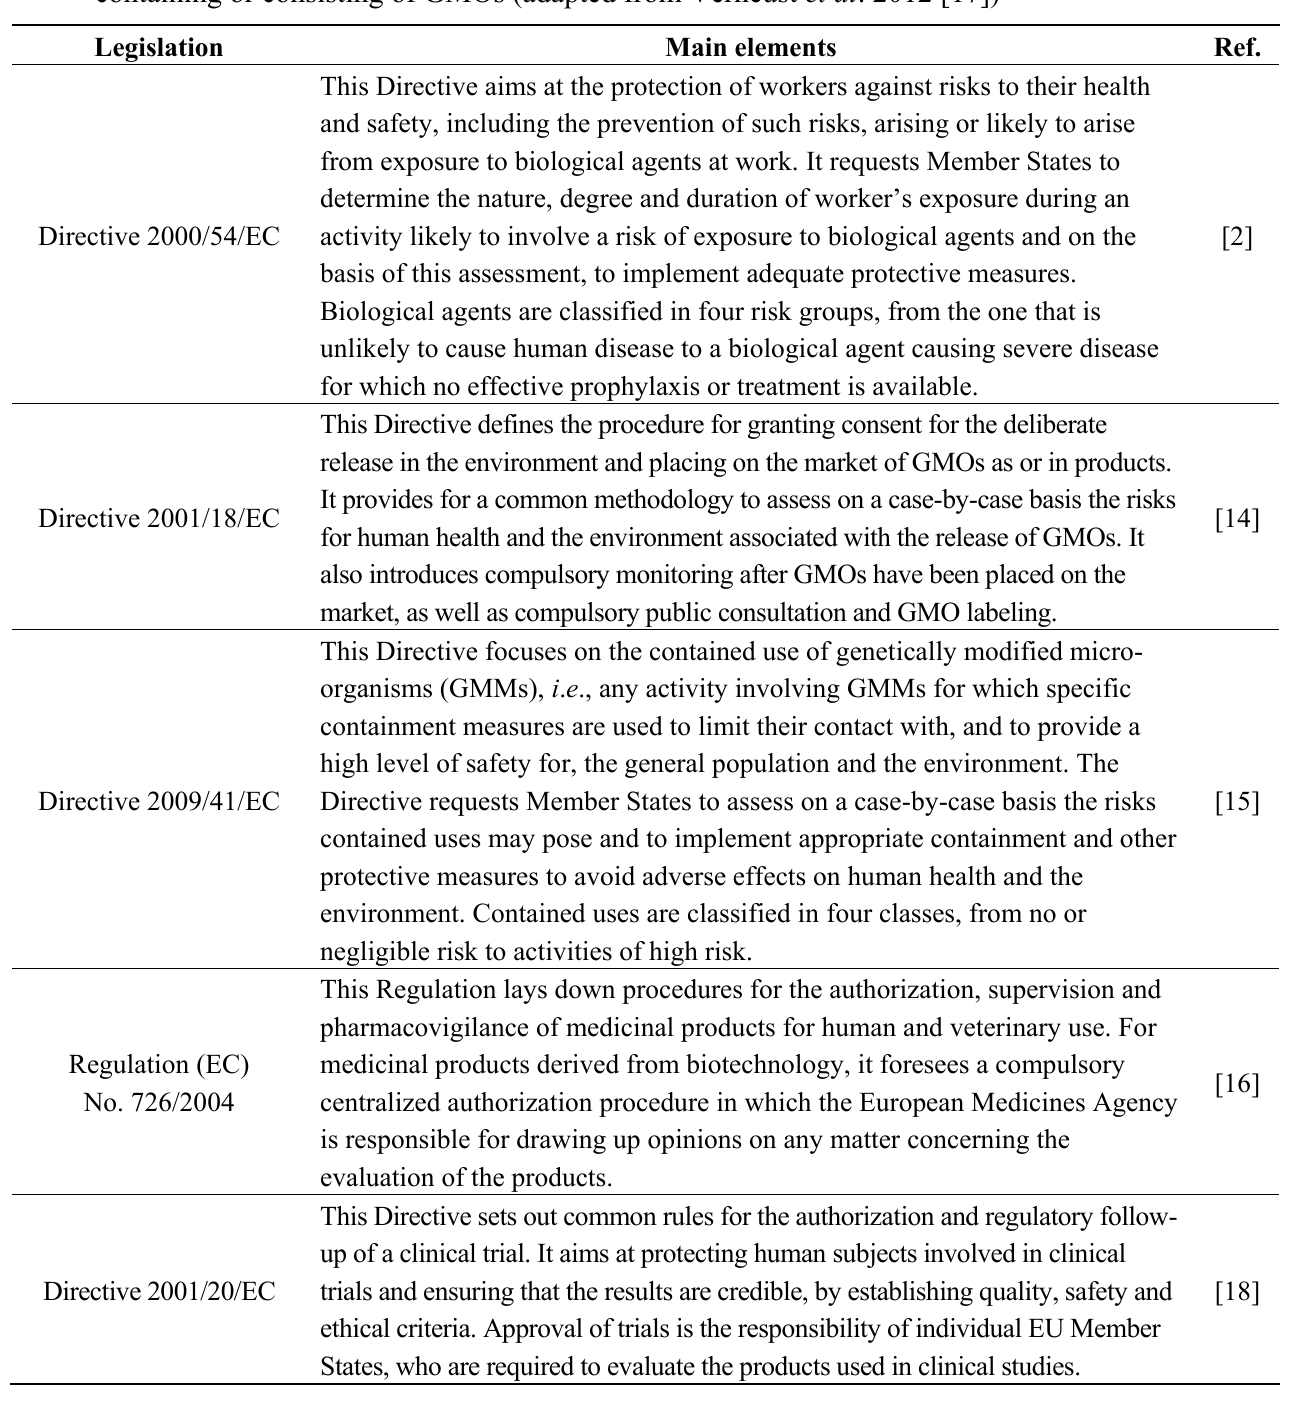
Table 1. EU’s regulatory framework governing the conduct of clinical trials using genetically modified organisms (GMOs) and/or pathogens and the marketing of medicinal substances containing or consisting of GMOs (adapted from Verheust et al . 2012